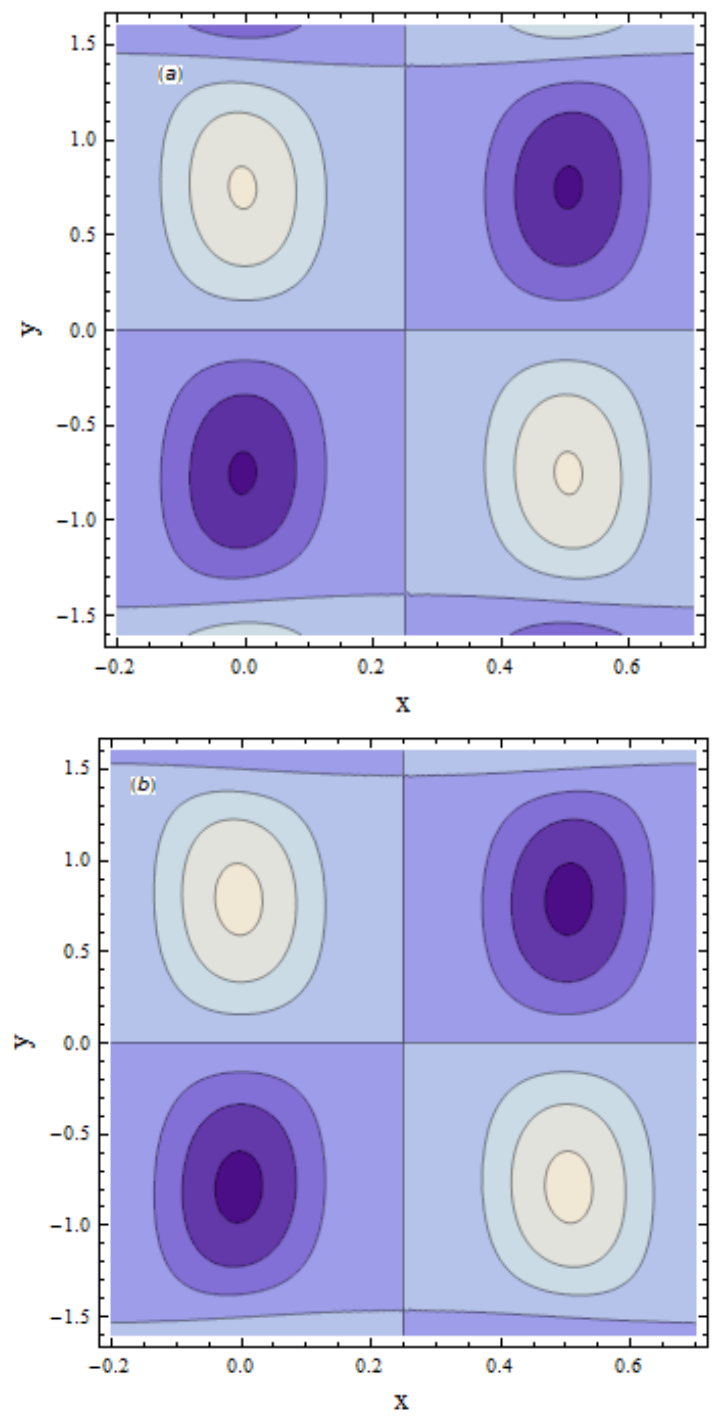
Figure 23. 𝜓 variation when ( a ) We = 0.1 and ( b ) We = 0.2. Figure 23. ψ variation when ( a ) We = 0.1 and ( b ) We =